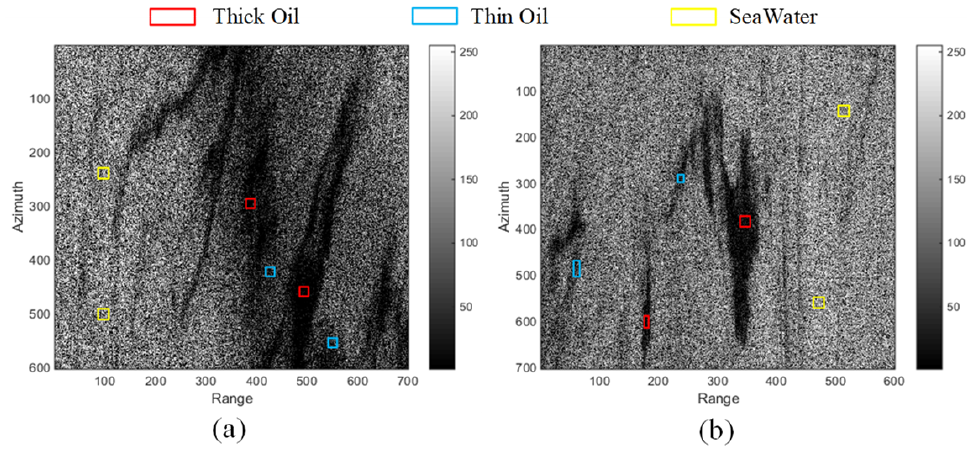
Figure 3. Span image of oil spill at sea: ( a ) Case 1; ( b ) Case 2.